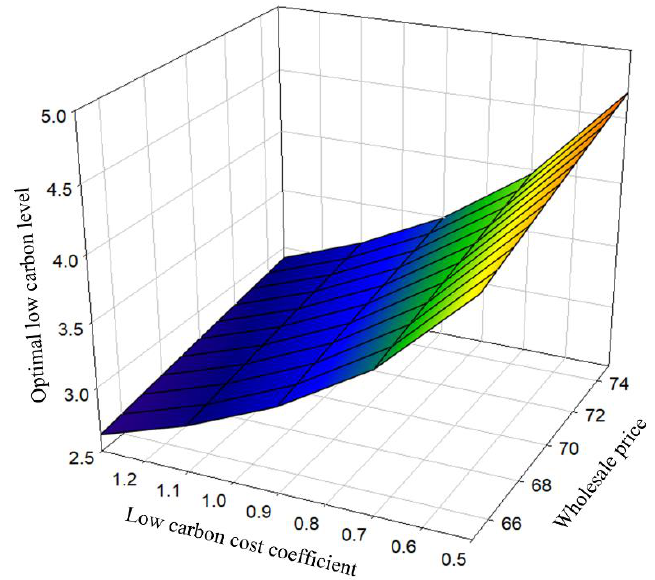
Figure 4. The impact of the low carbon cost coefficient and the wholesale price on manufacturers’ choice of optimal low carbon level.